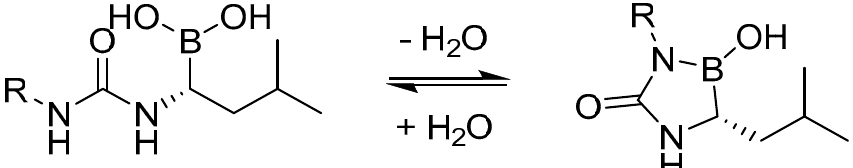
Figure 5. Possible formation of a cyclic boronic acid derivative, when boronic acid is located next to an urea group.